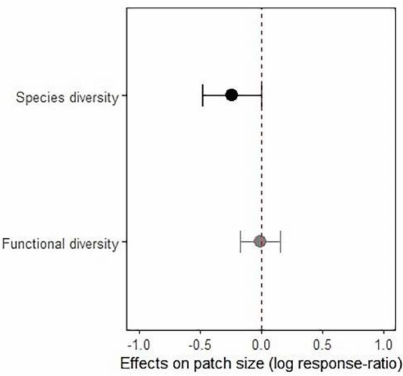
Figure 4. Disturbance effects on patch size (spatial range) of species and functional diversity. Shown in the figure is mean (solid point) and 95% confidence intervals (solid line). Statistically significant effects are shown in dark colour, and non-significant effects are shown in